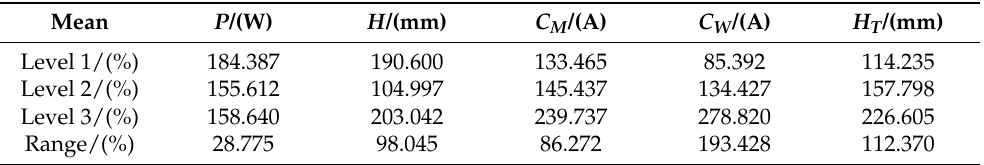
Table 4. Results of orthogonal experimental analysis of Δ S.